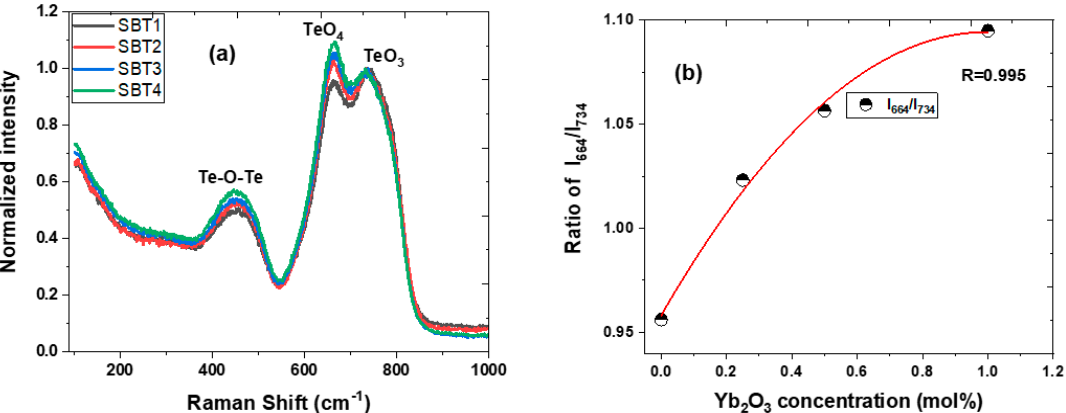
Figure 2. ( a ) Raman spectra of Sm 3+ /Sm 3+ :Yb 3+ -doped barium fluorotellurite glasses, ( b ) correspond- ing vibration intensity ratio of bridge oxygen to nonbridge oxygen atoms vs. Yb 2 O 3 concentration.